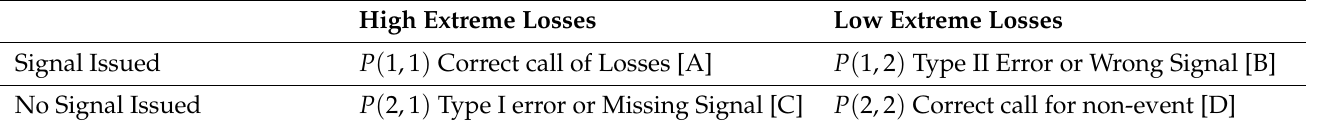
Table 5. Probabilities of correct and incorrect predicted Extreme